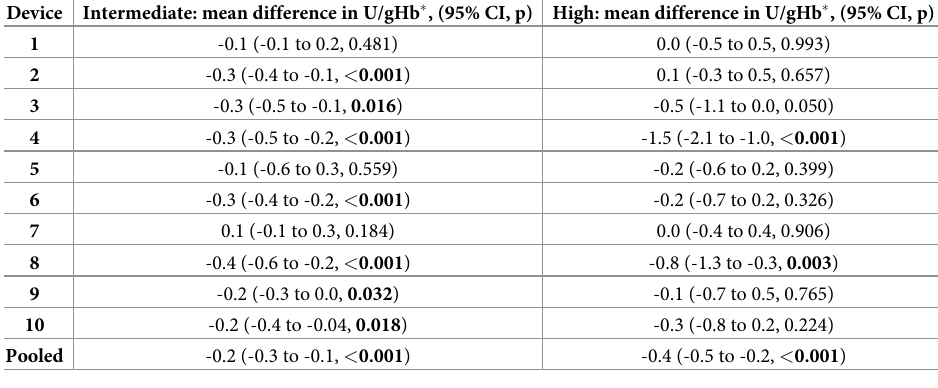
Table 4. Mean difference in G6PD activity for Intermediate and High controls by each Biosensor device between Phases A and B. Low controls were not directly comparable between Phases as these were from different